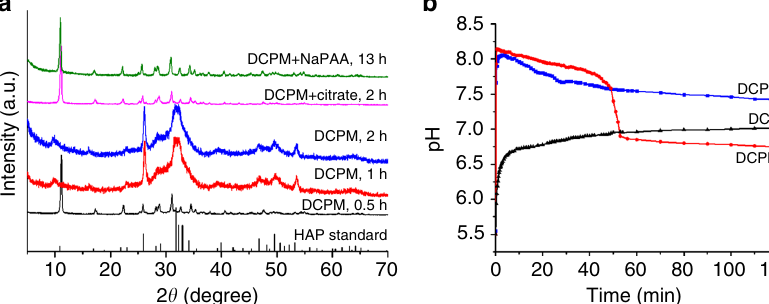
Fig. 5 Transformation of DCPM in water. XRPD patterns of particles ( a ) and corresponding pH change ( b ) retrieved after dispersing DCPM in water for different times. The sample obtained after 0.5 h shows the typical XRPD pattern of DCPM, indicating it did not transform during this time. Those obtained after 1 and 2 h show poorly crystallized HAP when compared to the HAP standard diffractogram shown at the bottom (JCPDS 09-0432). The pink and green curves in a were obtained from samples incubated in sodium citrate solution (pink) or NaPAA (green) for 2 h and 13 h, respectively, revealing the typical pattern of DCPM, indicating that citrate and NaPAA can signi fi cantly stabilize DCPM against transformation. Source data are provided as a Source Data fi